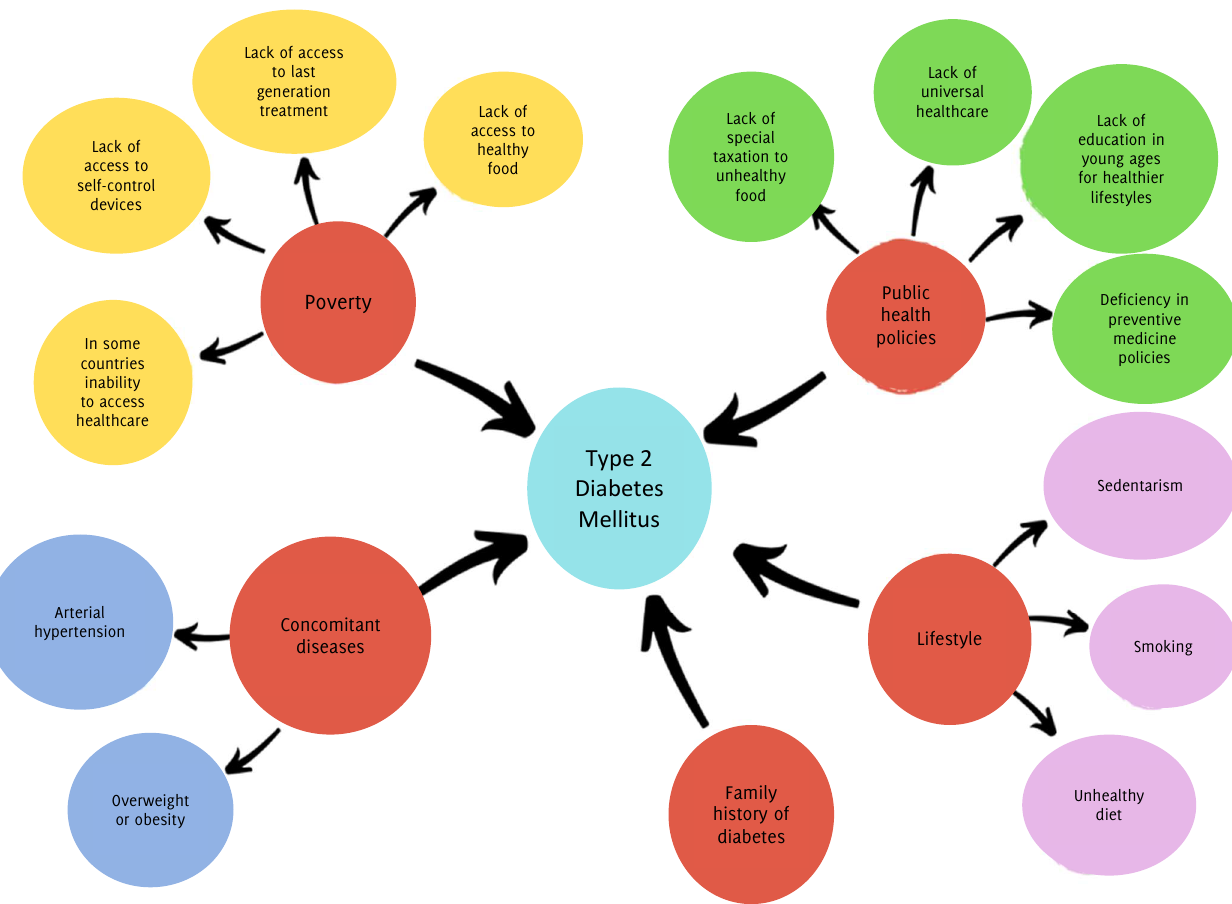
Figure 1. Risk Factors associated with the Development of Type II Diabetes